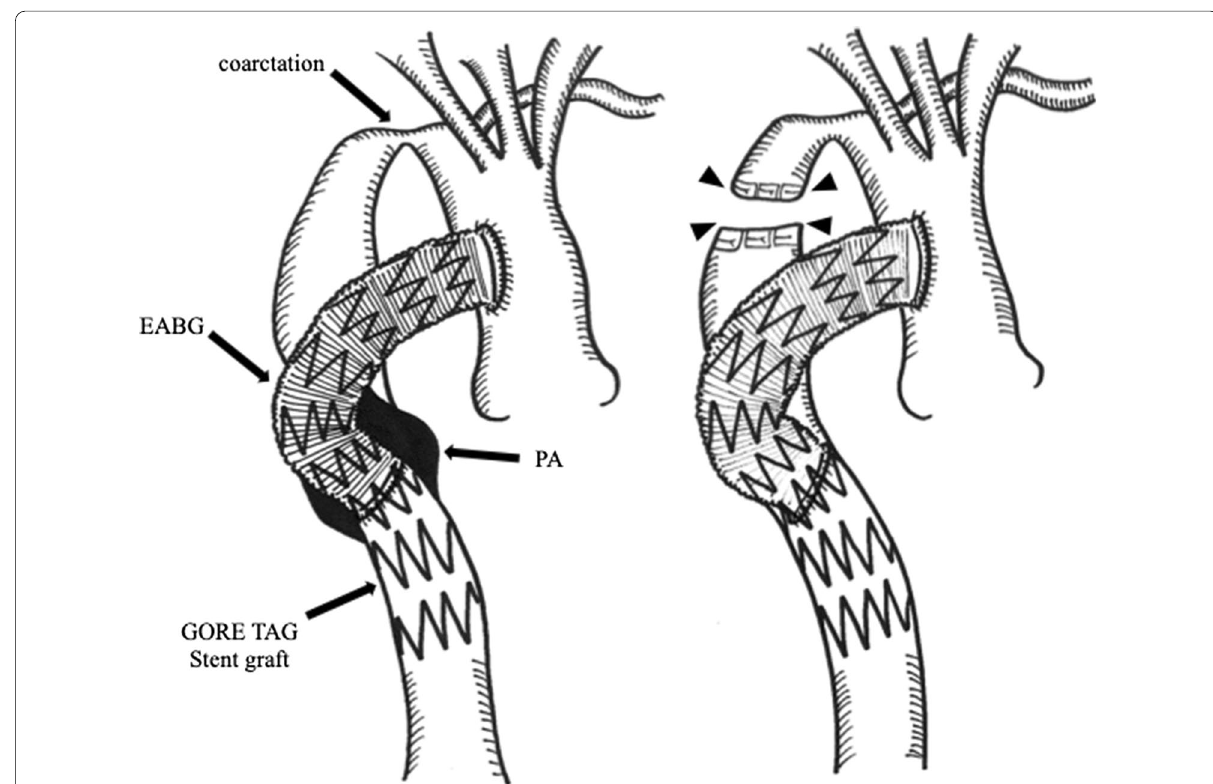
Fig. 2 Schematic images of the surgical procedures: preoperative ( a ) and postoperative ( b ). The arrowhead shows transected site of the descending aorta